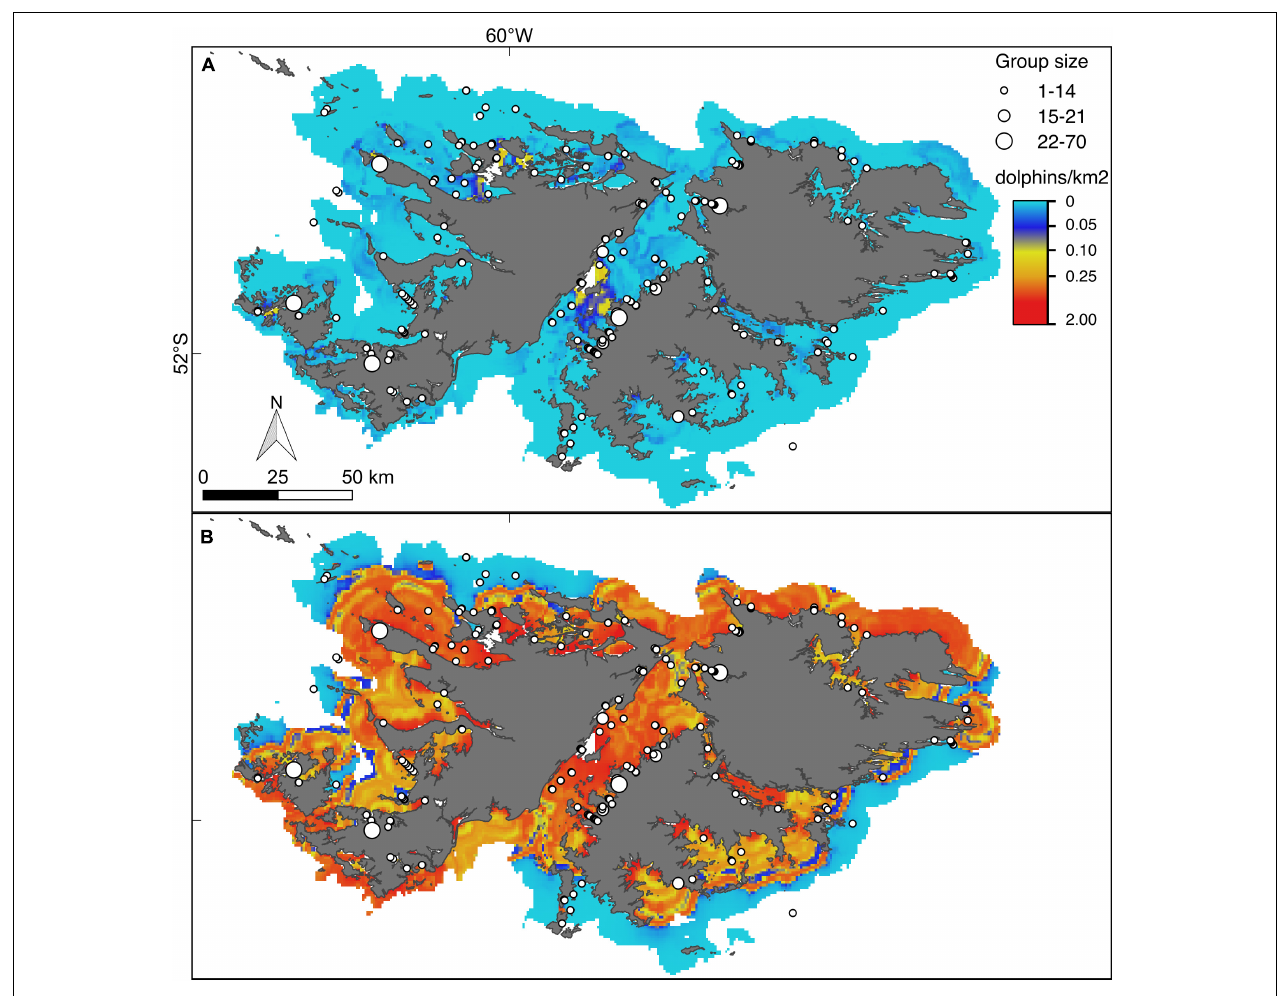
FIGURE 5 | Hurdle model lower (A) and upper (B) bounds of the 95% confidence interval for the predicted density (dolphins/km 2 ) of Commerson’s dolphins. For further explanation see Figure 4 .